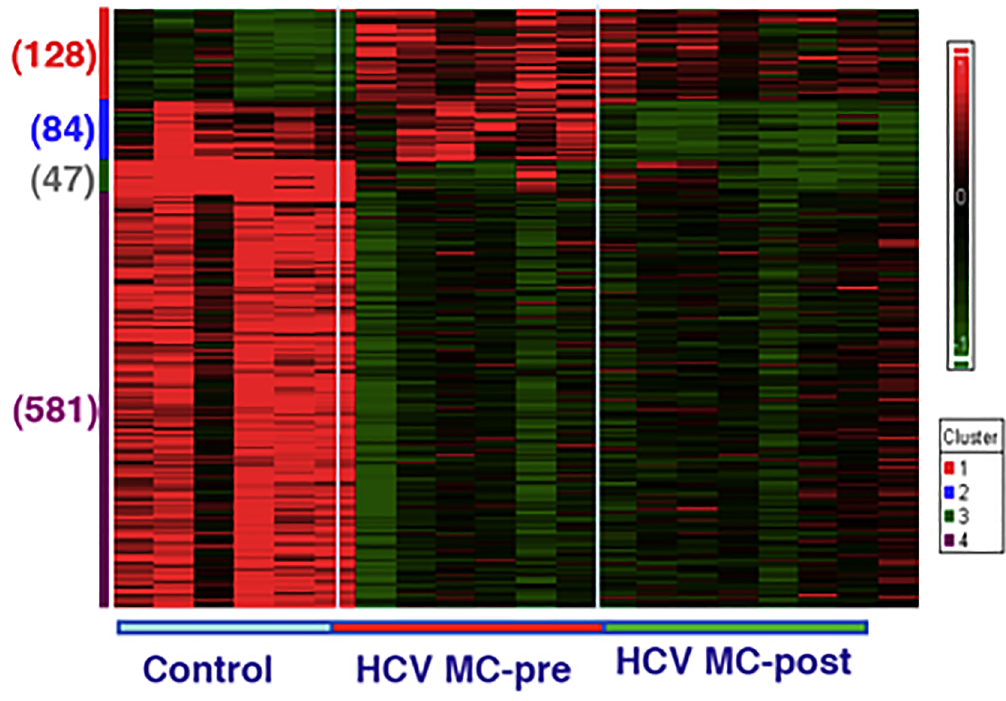
Fig 1. Clustering of differentially expressedgenes in PBMCs from two patient cohorts. Levels of gene expressionwere assayed using Affymetrix Human Genome U133Achips as describedin the methods section. A total of 529 differentially expressedgenes were identifiedfrom 20 total samples for 7 patients duringpre and post treatment. All samples were hybridized on Hu133plus 2.0. Genes were selectedby filters: P value < = 0.05 and Fold Change2 in any of the above4 comparisons. Genes were groupedusing K -meansclustering and sampleswere groupedby hierarchical clustering. Differences in relative levels of gene expression( Z -score) are representedby color; red indicatesup-regulation whilegreen indicates down-regulationcorresponding to gene expressionin controls. The numbers in the parenthesis on the left signify the number of genesin each cluster. Cluster 1 representsgenes down-regulated in HCV mono-infected patients and HCV MC vasculitis patients. Cluster 2 representsgenes up- regulatedin HCV mono-infected patients without vasculitis. Cluster 3 represents genesup-regulated in HCV MC vasculitis patients and Cluster 4 represents genes down regulatedin HCV MC vasculitis patients.